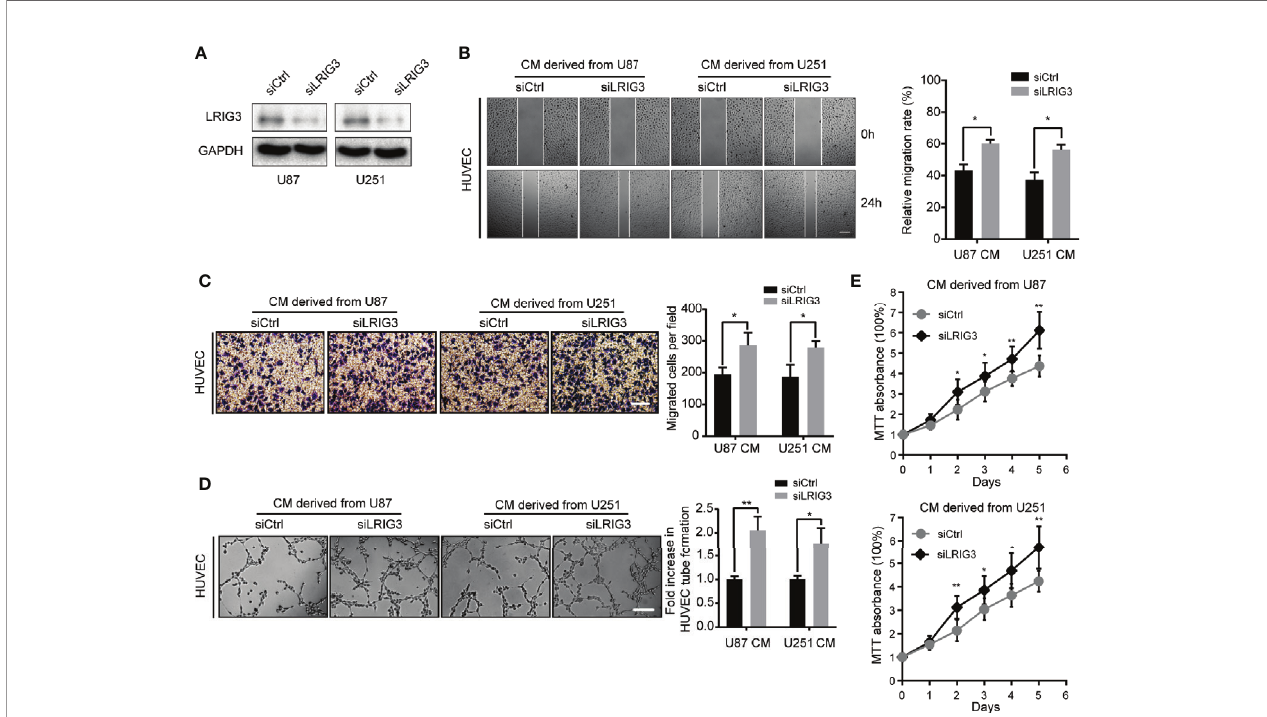
FIGURE 2 | Downregulation of LRIG3 enhances the pro-angiogenic activity of glioma cells in vitro . (A) Western blot analysis of LRIG3 expression in the siRNA control and LRIG3-silenced glioma cells. GAPDH was used as an internal control. (B) Representative images (left) and quanti fi cation (right) of wound healing assays of HUVECs treated with CM derived from the siRNA control or LRIG3-silenced glioma cells. (C) Representative images (left) and quanti fi cation (right) of transwell migration assays in HUVECs treated with the indicated CM. (D) Representative images (left) and quanti fi cation (right) of HUVECs formed tube-like structures on Matrigel-coated plates with CM derived from the siRNA control cells or LRIG3-silenced glioma cells. (E) HUVEC viability was determined using the MTT assay. HUVECs were treated with CM derived from the indicated cells for the speci fi c number of days. Data are presented as means ± SD of 3 independent replicates. * p < 0.05; ** p < 0.01. CM, conditioned